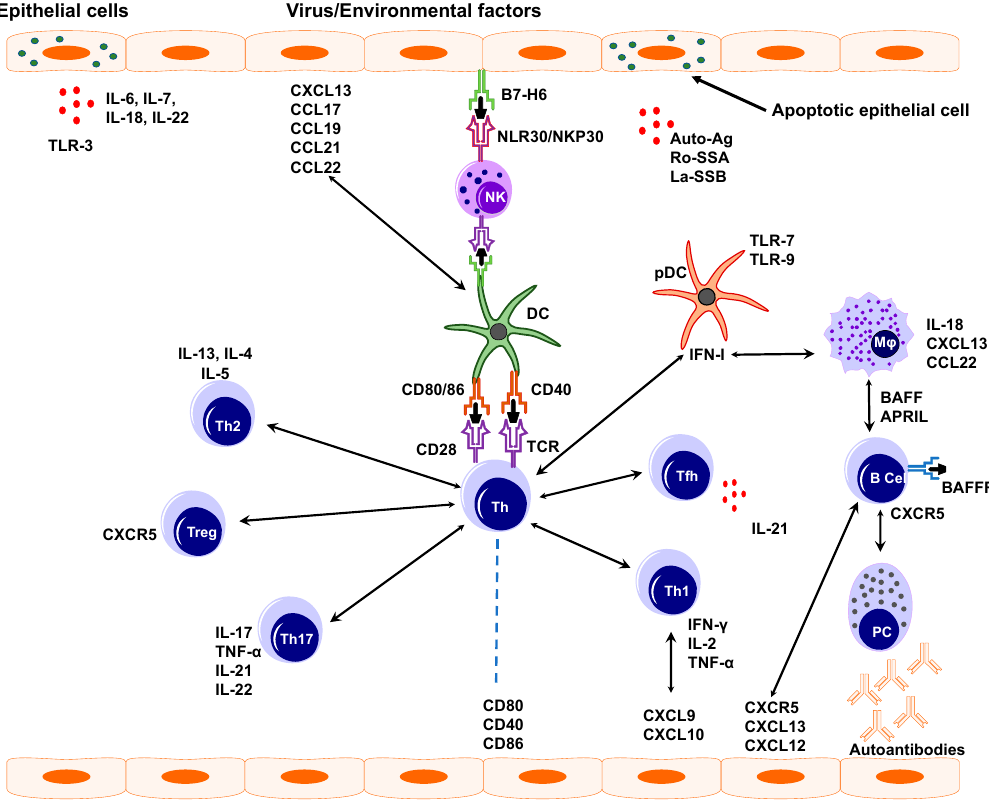
Figure 4. Pathogenesis of Sjögren’s syndrome. Virus or other environmental factors cause epithelial cell activation that will then express ligands, receptors, and various cytokines such as IL-6, IL-22, and chemokines like CXCL13. These further activate several other immune cells like natural killer cells (NK), dendritic cells (DCs), and macrophages (M ϕ ). Conventional dendritic cells interact with NK cells and T helper cells (Th) leading to increase IFN- γ production and tissue damage. IFN-1 and IFN- γ enhance BAFF production which leads to B and T cell activation. Activated B cells produce pathogenic autoantibodies.